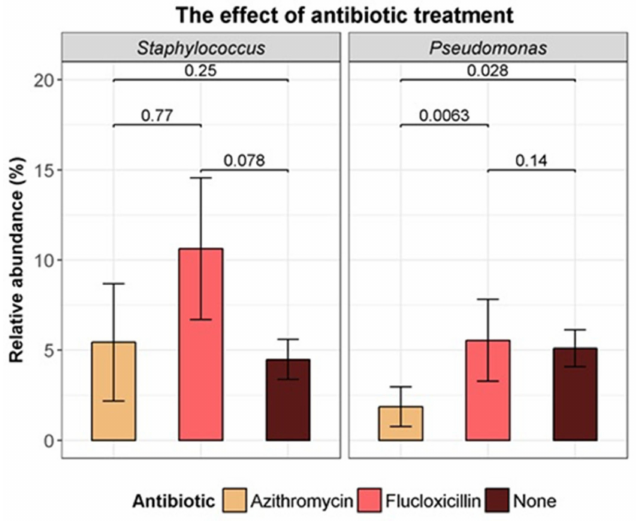
Figure 6. Comparison of relative abundance of Staphylococcus genus and Pseudomonas genus with flucloxacillin prophylaxis, and long-term azithromycin treatment, on the day of the bronchoscopy (Kruskal–Wallis